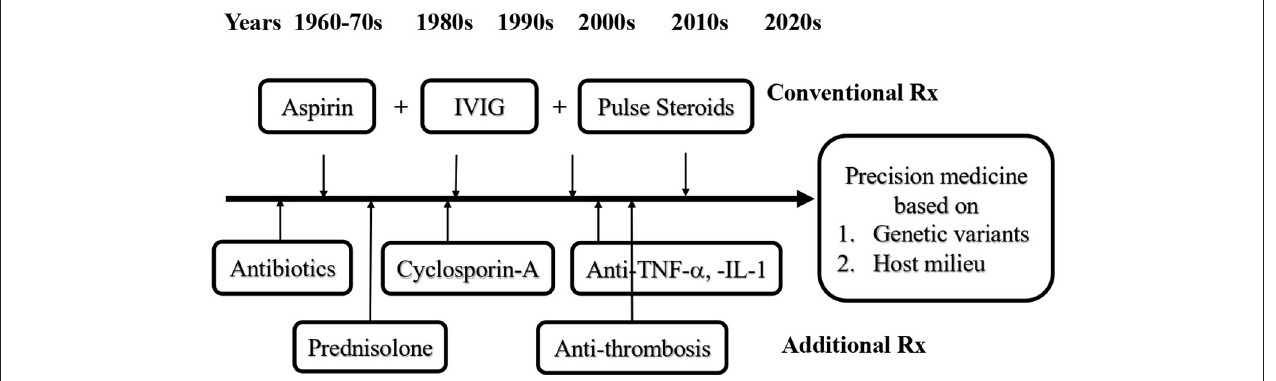
FIGURE 1 | Evolvement of immunotherapies for Kawasaki disease (KD). The conventional treatment (Rx) for KD has been evolved from antibiotics, aspirin, corticosteroids, IVIG and aspirin plus IVIG, aspirin, and/or pulsed corticosteroids through the past 50 years. In KD patients with IVIG resistance or KDSS, additional Rx for refractory KD requires cyclosporin-A, anti-cytokines, and/or anti-thrombotic treatment, depending on the complications. In the era of precision medicine, to screen and to understand the genetic variants and internal milieu of KD patients in advance may help to prevent KD in patients from IVIG resistance or